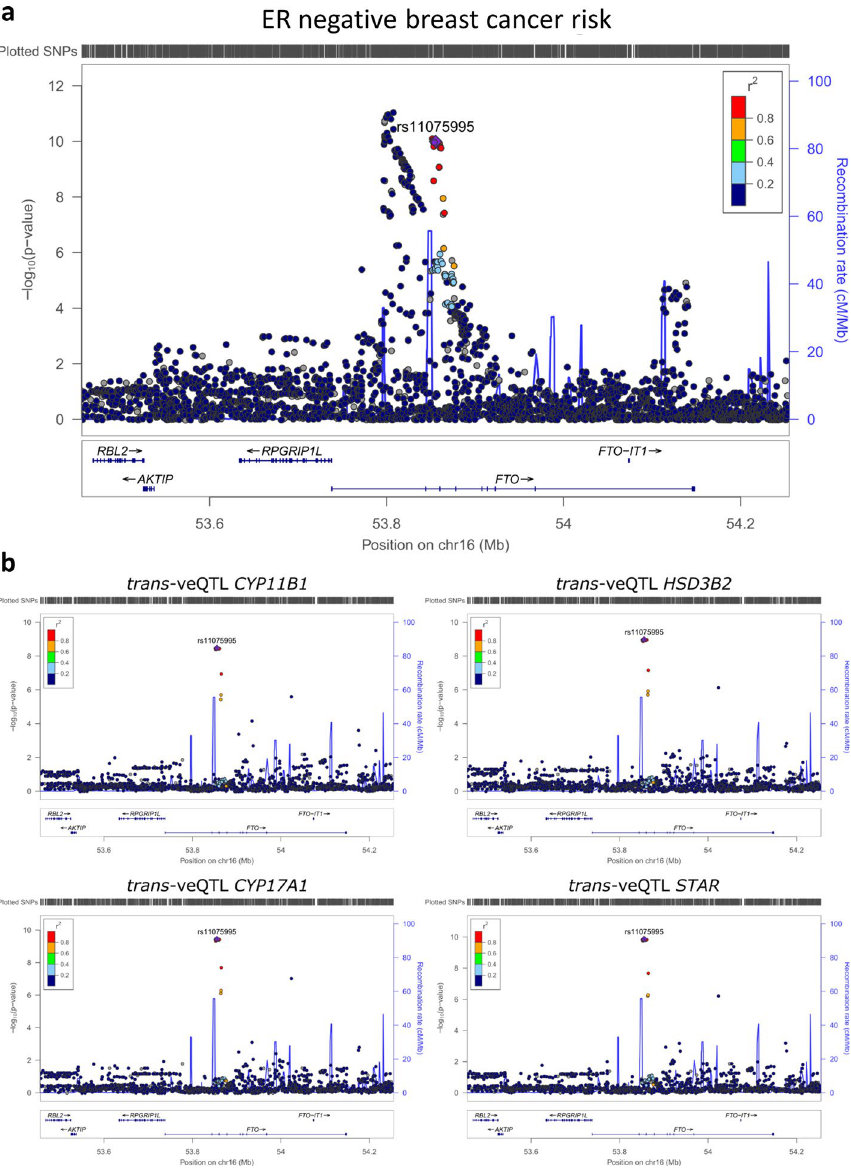
Figure 5. Co-localisation of ER negative breast cancer GWAS and trans-veQTL signals. ( a ) Regional association plots for ER negative breast cancer risk for rs11075995 from Michailidou et al. 3 . ( b ) Regional association plots for trans-veQTL at rs11075995. Points indicate individual SNPs at their chromosomal location and significance (− log10( p value)) for either GWAS ( a ) or trans-veQTL ( b ). The blue line represents the recombination rate and the colour of the points indicate the strength of the LD with rs10075995 measured as r2 in the EUR population from 1000 genomes (hg19). All plots were generated using